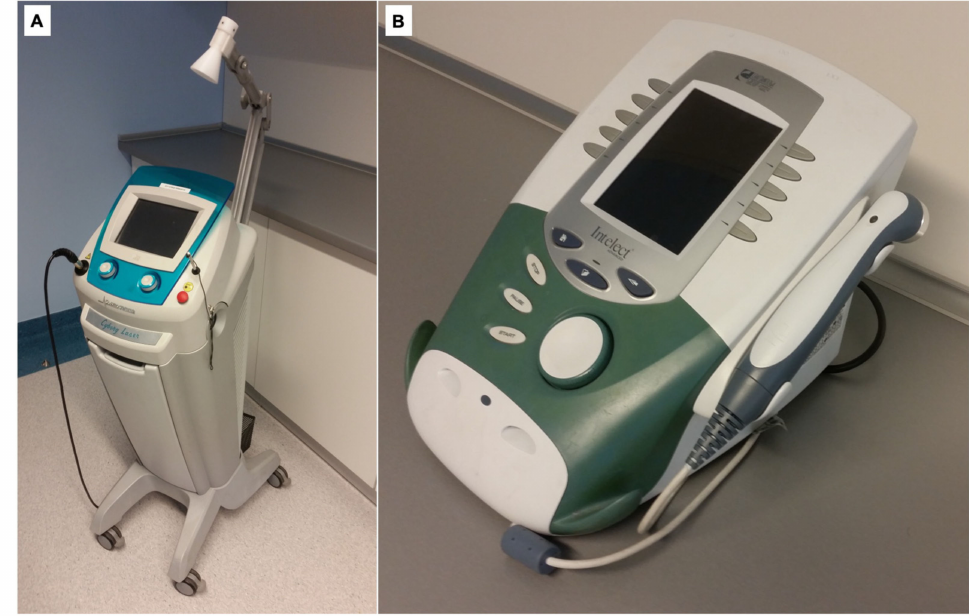
Figure 2. The devices for HILT ( A ) and ultrasound ( B ) treatment